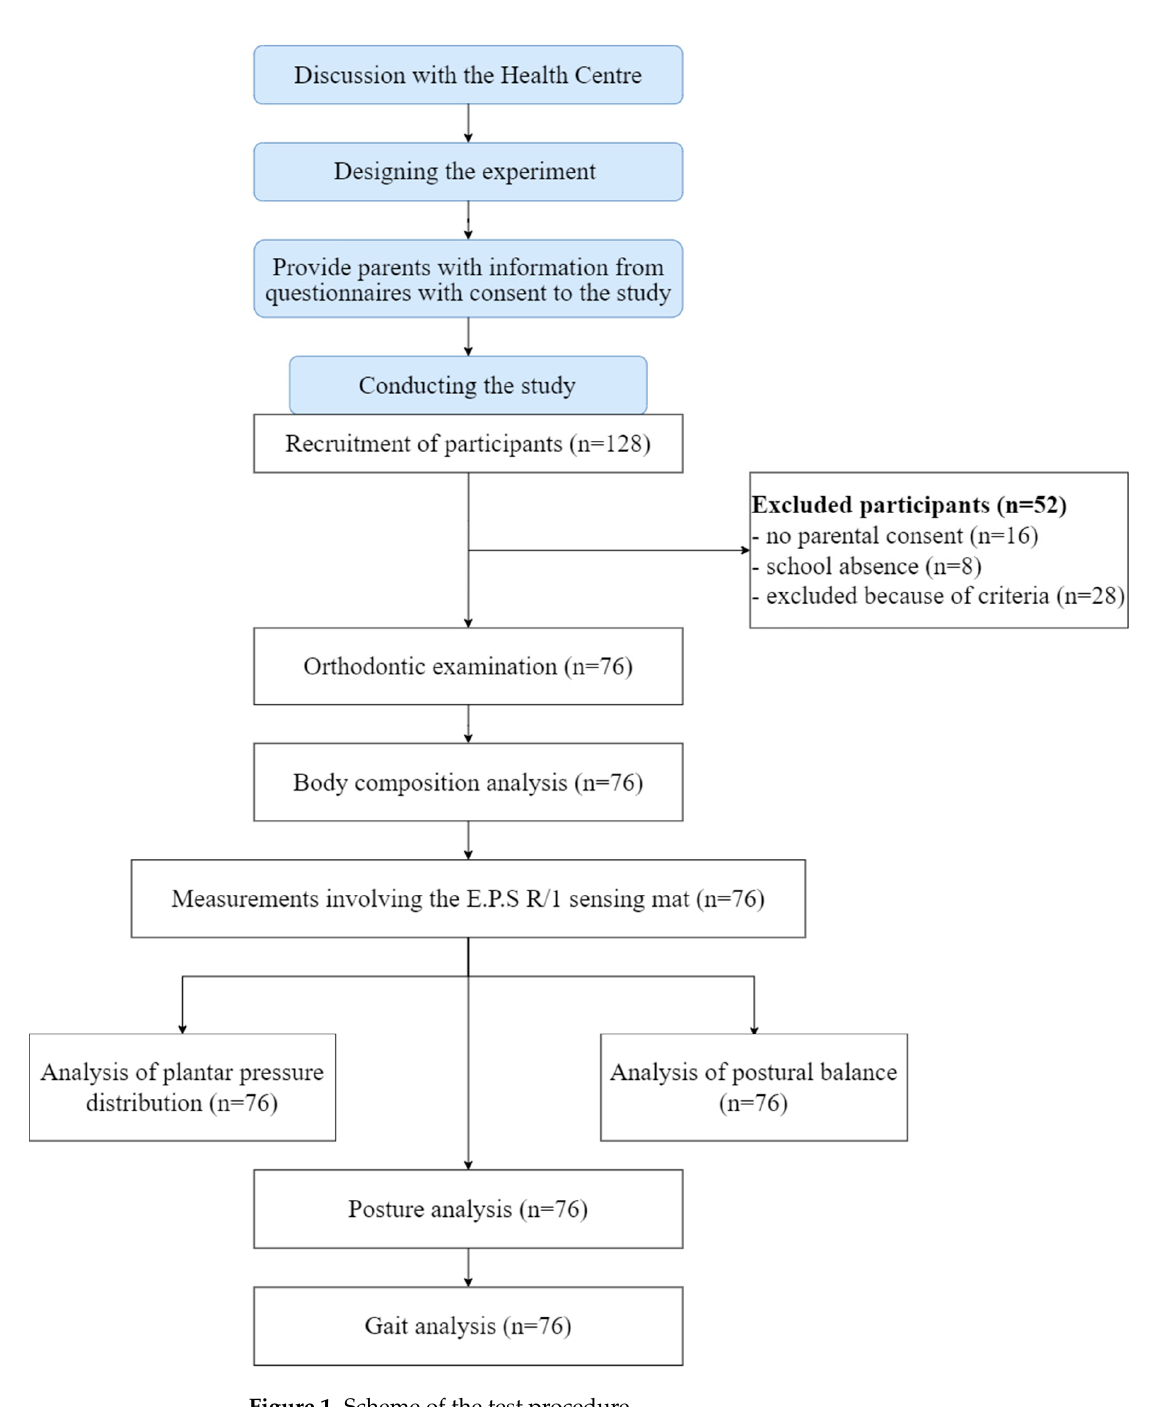
Figure 1. Scheme of the test procedure.